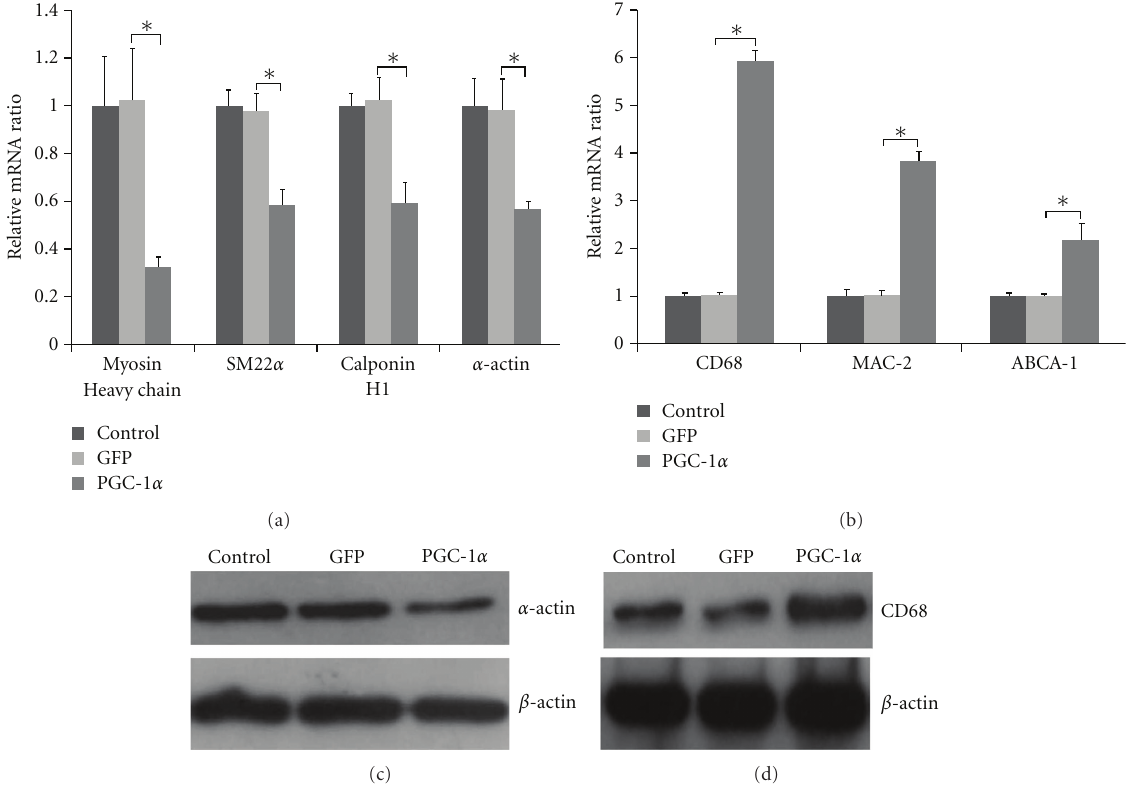
Figure 3: Overexpression of PGC-1 α downregulated VSMCs-specific genes and upregulated macrophage-specific genes. (a) Downregulation of VSMCs-specific genes ( ∗ P < 0 . 05), (b) upregulation of macrophage-specific genes ( ∗ P < 0 . 05), (c) Western blotting analysis for α -actin in VSMCs, and (d) Western blotting analysis for CD68 in